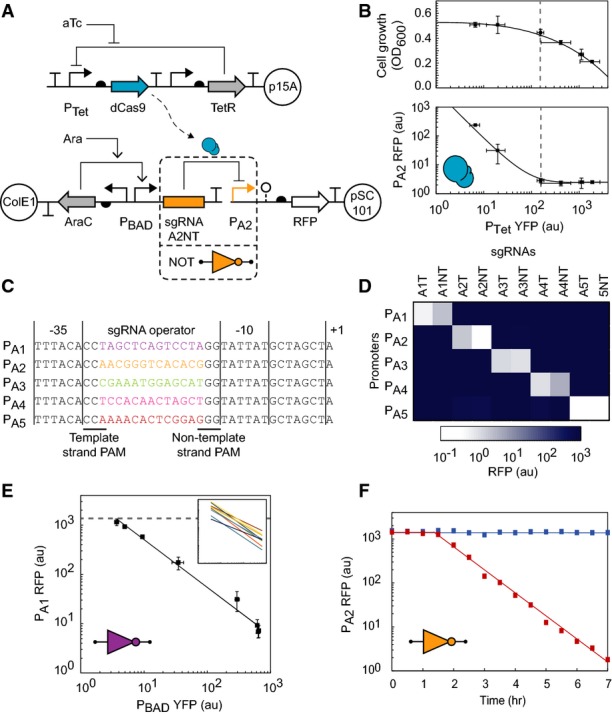
Characterization of dCas9 and orthogonal sgRNA NOT gatesThe inducible dCas9 and sgRNA system comprises a medium-copy plasmid with
PTet-inducible dCas9, a high-copy plasmid with PBAD-inducible sgRNAs, and a
low-copy plasmid encoding a synthetic sgRNA-repressible promoter driving RFP.When sgRNA-A2NT is constitutively induced, increasing dCas9 expression causes greater repression
of PA2 (lower panel), at the cost of decreased cell growth (upper panel). All samples
were grown in the presence of 2 mM arabinose. Concentrations of aTc used from left to right (ng/ml):
0.0391, 0.313, 0.625, 1.25, 5, and 10. A single intermediate expression value for dCas9 was used for
the remaining experiments (0.625 ng/ml aTc, dashed lines).Synthetic repressible promoters designed by modifying the sequence of promoter BBa_J23101. The
−35 and −10 σ70 binding sites flank forward and reverse
“NGG” protospacer adjacent motifs (PAMs) and a promoter-specific 13 bp sgRNA operator.
An sgRNA bound to dCas9 will base pair with one strand of a promoter's sgRNA operator and one
of the σ70 binding sites, causing steric repression of transcription initiation.
In the absence of repression, transcription of the downstream RNA begins at the +1 site.The crosstalk map for all combinations of sgRNAs and synthetic promoters is shown. The heat map
indicates the amount of RFP observed for that sgRNA-promoter pair. Only cognate pairs of sgRNAs and
promoters exhibit significant repression, whereas non-cognate pairs interact negligibly. Samples
were grown in the presence of 0.625 ng/ml aTc and 2 mM arabinose.The response function for sgRNA-A1T measured by expressing intermediate levels of sgRNA-A1T
reveals a non-cooperative, log-linear relationship between the input and output promoters. The solid
line visualizes a power law fit to the data points. Error bars represent the standard deviation of
fluorescence geometric mean for three independent experiments on different days. The reporter
expression when dCas9 is not induced is shown (dashed line), and all other samples were grown in the
presence of 0.625 ng/ml aTc. Concentrations of arabinose used from left to right (mM): 0, 0.0313,
0.0625, 0.125, 0.25, 0.5, 1, and 2. Inset: The power law fits for each of the 10 sgRNAs and their
cognate promoters (data presented in Supplementary Fig S3); axes values are the same as the
encompassing figure.The temporal dynamics of dCas9 and sgRNA induction are shown. Red squares indicate induction of
both dCas9 (0.625 ng/ml aTc) and sgRNA-A2NT (2 mM arabinose) commencing at t
= 0 h. Blue squares indicate uninduced cultures. After a ˜90-min delay, fluorescence
decreases concomitantly with cell dilution—occurring at a rate of 33 min per doubling.